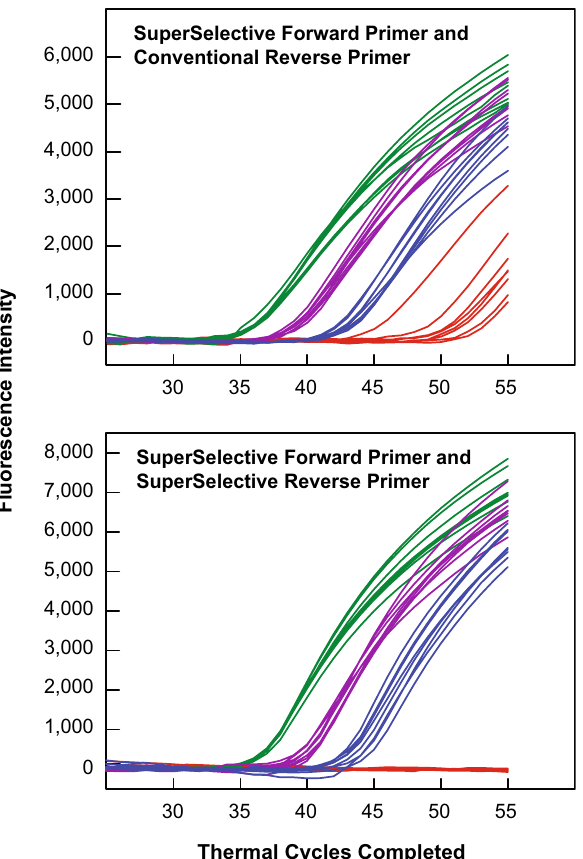
Figure 2. Demonstration of the selectivity of PCR assays that utilize a pair of SuperSelective primers for the amplification of rare mutant DNA fragments in the presence of abundant DNA fragments from the entire human genome. All of these reactions contained DNA fragments from 10,000 normal human genomes, including 10,000 copies of the wild-type KRAS sequence. In addition, these reactions contained different quantities of a linearized plasmid containing the KRAS G12C mutant target sequence: either 1,000 copies (shown in green), 100 copies (shown in purple), 10 copies (shown in blue), or 0 copies (shown in red). Each reaction was repeated eight times. The top panel shows the results that were obtained when only one of the primers for the KRAS mutant target was SuperSelective; and the bottom panel shows the results that were obtained when both primers for the KRAS mutant target were SuperSelective. When only one of the two primers was SuperSelective, false-positive signals arose when no KRAS mutant targets were present in the sample. When both primers were SuperSelective, the false-positive signals were